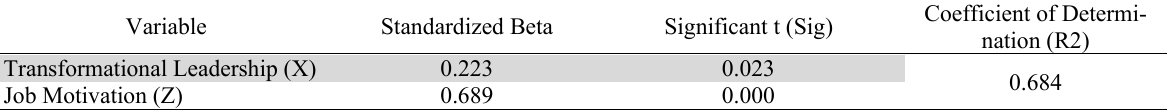
Results of Regression Analysis of Transformational Leadership (X) and Job Motivation (Z) toward Job Performance (Y)